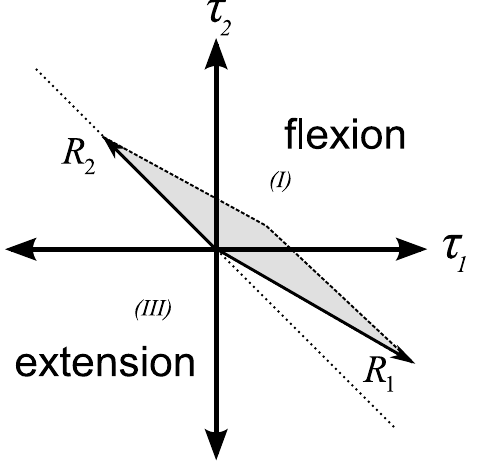
Figure 5. The space of feasible joint torques. It represents the pos- itive span of R i , given upper bounds on the tensions. Region (I) in- dicates when both joints are in flexion. Region (III) indicates when both joints are in extension.